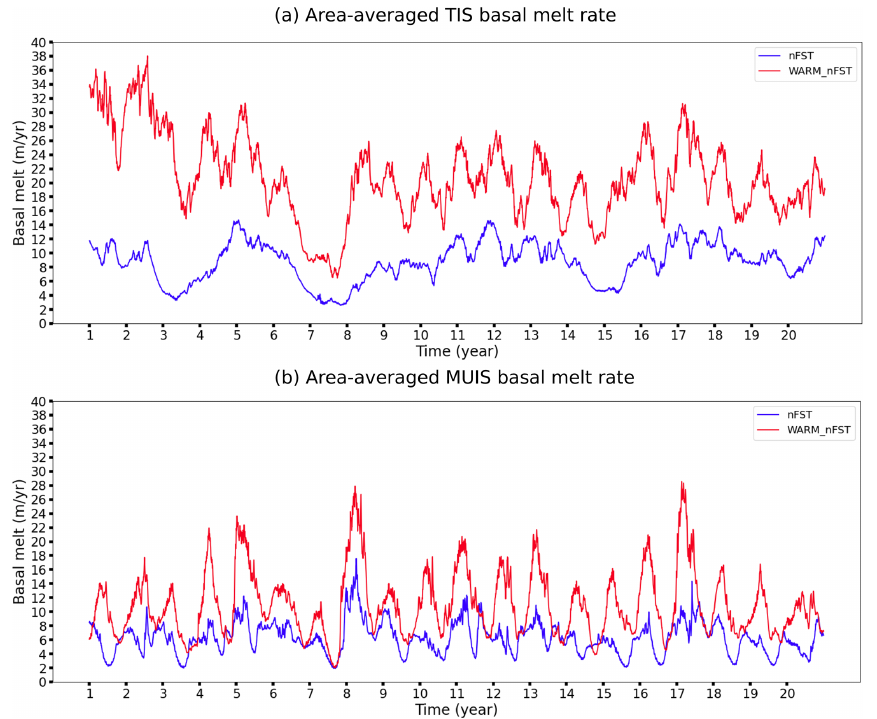
Figure 12. Time series of the area-averaged TIS (a) and MUIS (b) basal melt rates from nFST (blue) and nFST_WARM (red). The timescales are 1995–2014 and 2018–2100 for the recent past simulations (blue) and the future climate conditions (red), respectively. The time periods are 1995–2014 for nFST and 2081–2100 for nFST_WARM. TIS melt rates are 8 . 74 ± 2 . 76myr − 1 in nFST and 20 . 68 ± 5 . 87myr − 1